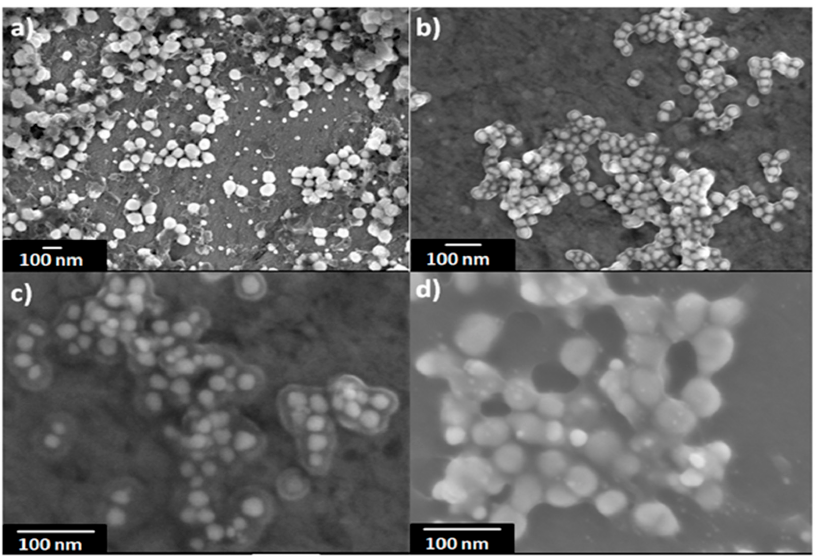
Figure 5. SEM images for the sample 16 at different magnifications, ( a ) 50,000×, ( b ) 100,000×, ( c ) 200,000×, ( d ) 220,000×.